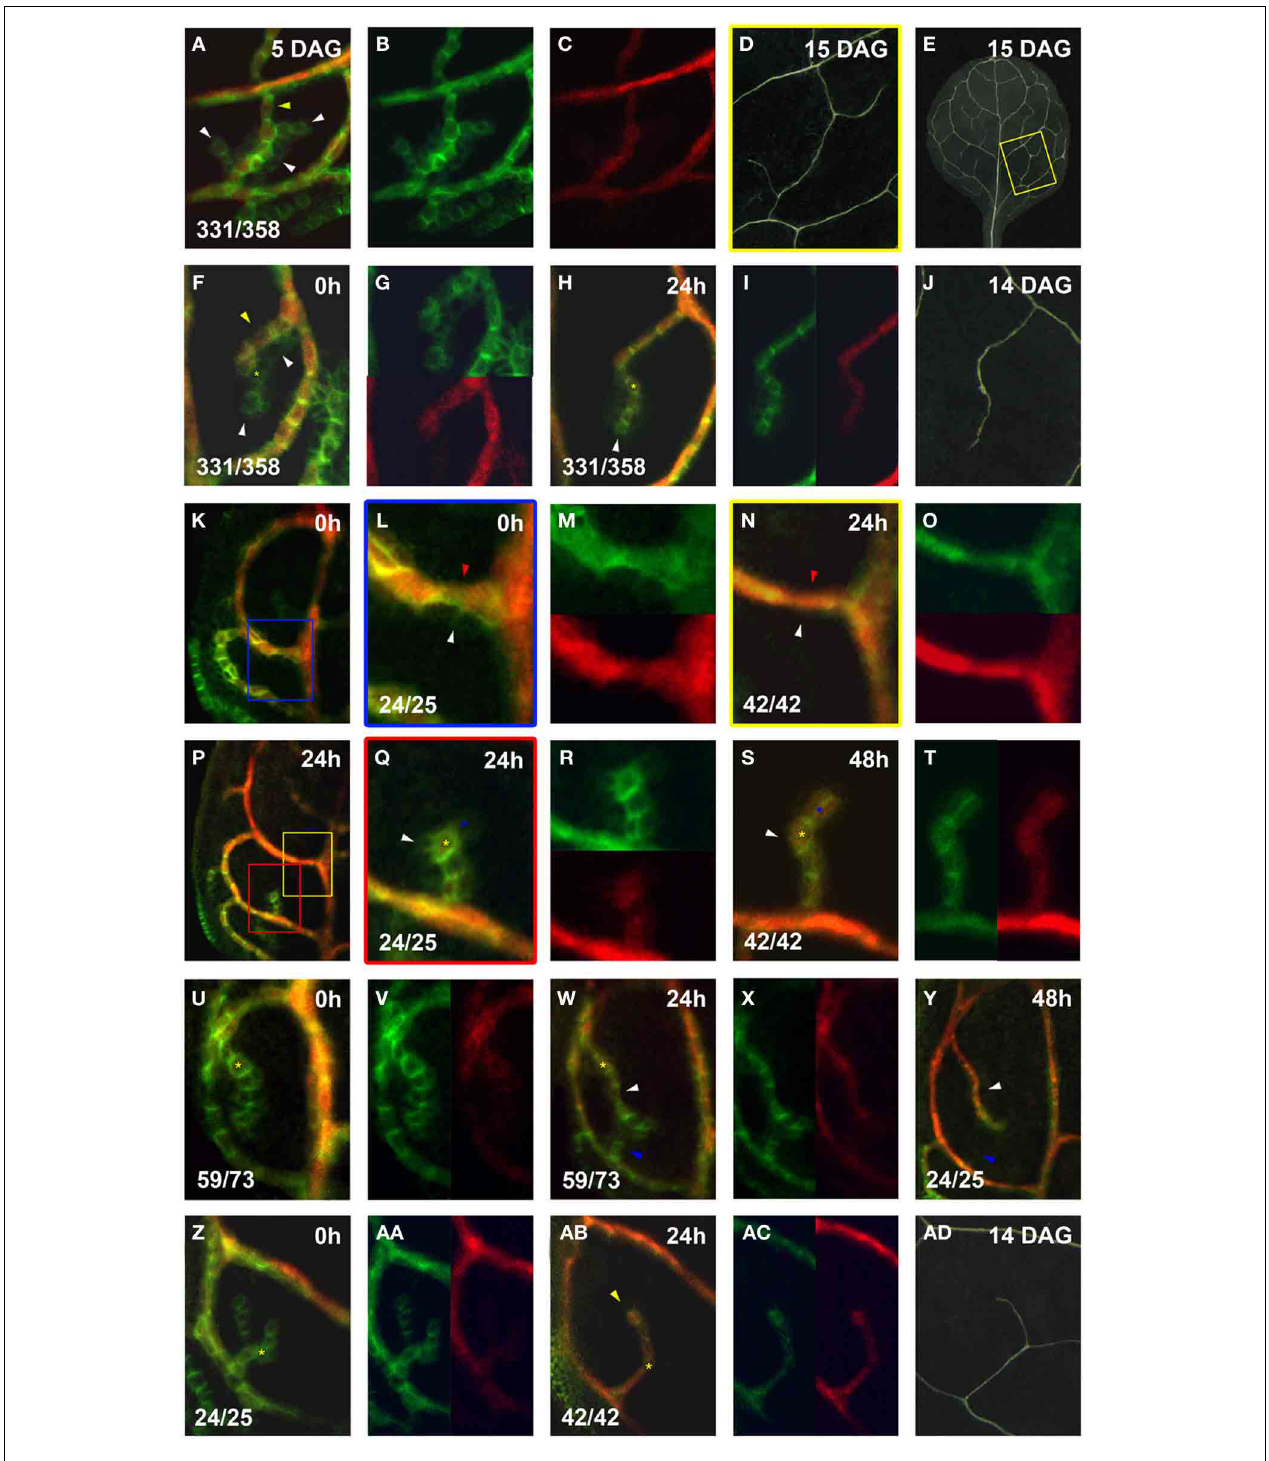
FIGURE 7 | Co-expression of PIN1:GFP and Athb8::YFPer during vein formation. PIN1:GFP (green) and Athb8::YFPer (red). Top left, time after first imaging ( t = 0; F,H,K,L,N,P,Q,S,U,W,Y,AC,AD ) or at leaf age in DAG (A,D,E,J,AD) . Bottom left, reproducibility quotient ( Table 2 ). Scale bars: (A,F–H,L–N,Q–AB) 10 µ m; (D,E) 1mm; (J,AD) 0.5mm; (K,P) 20 µ m. (A–E) Area enclosed by the third loop. Co- (A) and separate (B,C) expression of